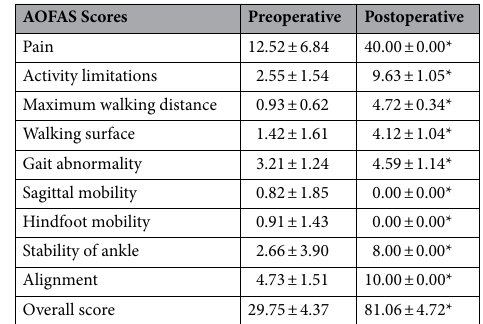
Table 1. AO-FAS score of the fifteen patients. * P <